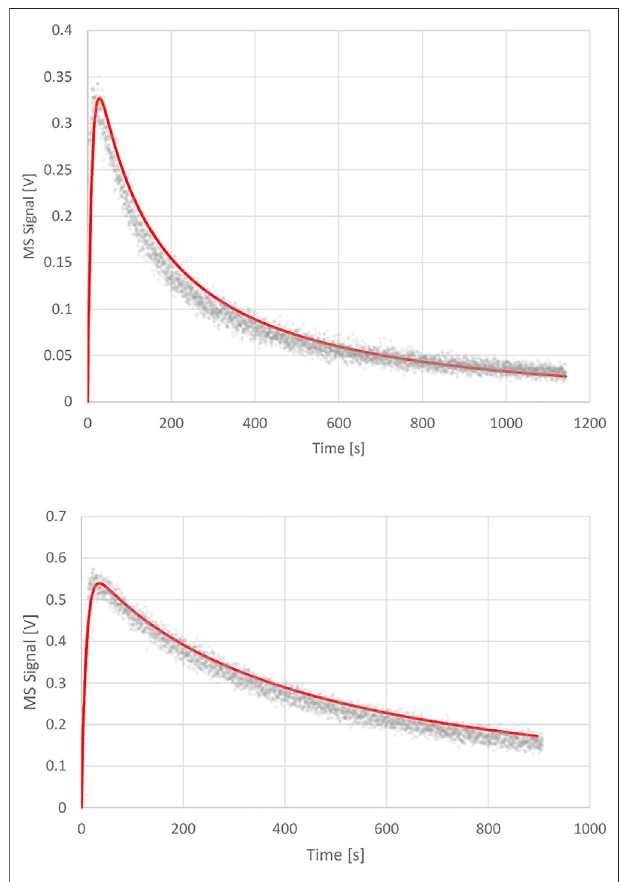
FIGURE 6 | Upper Panel: Desorption experiment (FS 90/91) pipol acetate + ATD Coarse, 1 mm Ø ori fi ce KFR, kinetic parameters: k e (pipol acetate) = 0.0988 s − 1 , k a = 1.2 s − 1 , k d = 7.0 × 10 − 4 s − 1 ; Lower Panel: Desorption experiment (S101 PAC + TFA) tri fl uoroacetic acid (TFA) + Processed Amorphous Carbon (PAC), 1 mm Ø ori fi ce KFR, kinetic parameters: k e (TFA) = 0.114 s − 1 , k a = 2.3 s − 1 ; k d = 1.2 × 10 − 4 s − 1